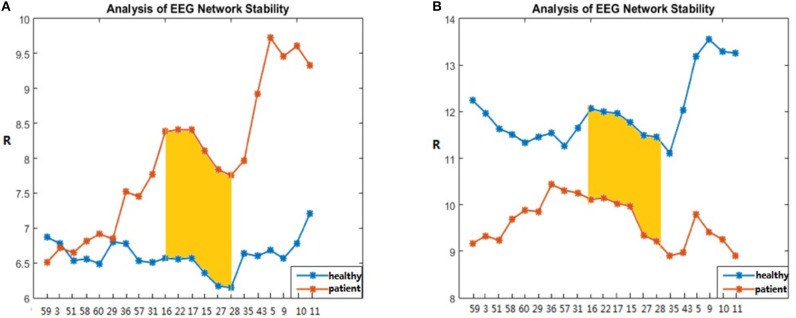
R-value changes with the coupling of the S area in patients and healthy controls. The patient subject graphed here was #6 and the healthy control subject was #4 in (A), and the patient subject graphed in (B) was #4 and the healthy control subject was #6.